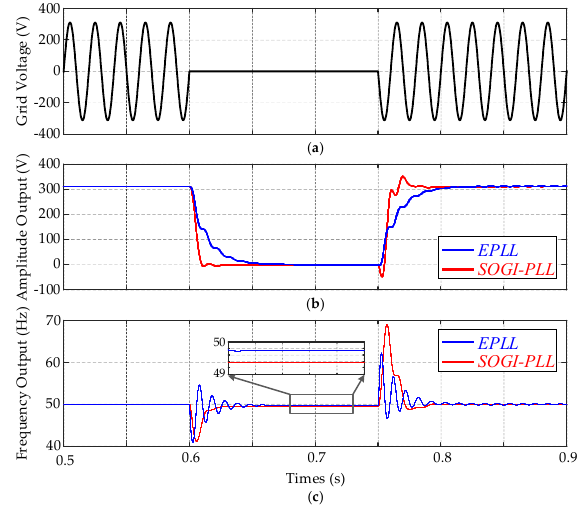
Figure 7. Performance comparison of the selected PLLs under a voltage sag depth of 100% (i.e., zero-voltage fault): ( a ) grid voltage; ( b ) PLL estimated voltage amplitude output; ( c ) PLL estimated frequency output.